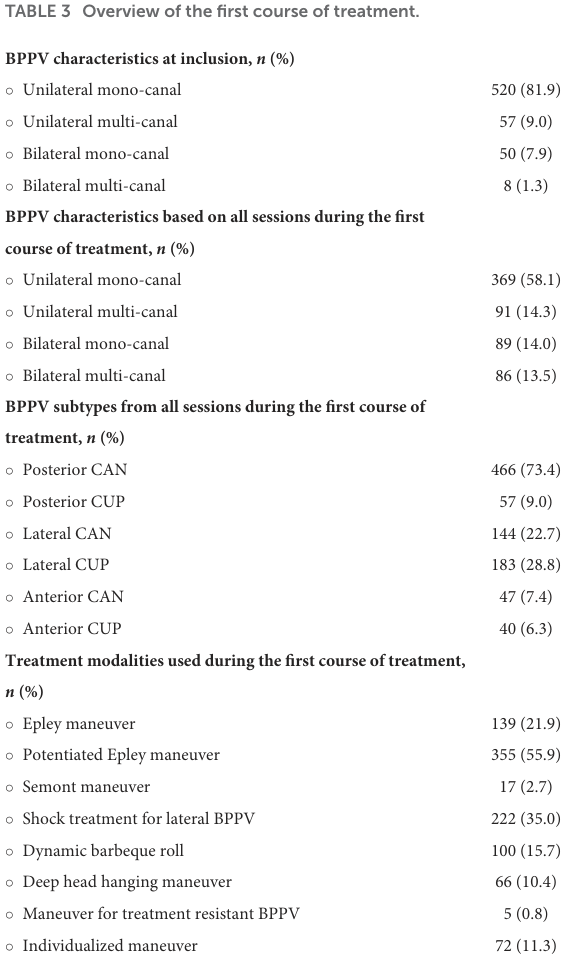
TABLE 3 Overview of the first course of